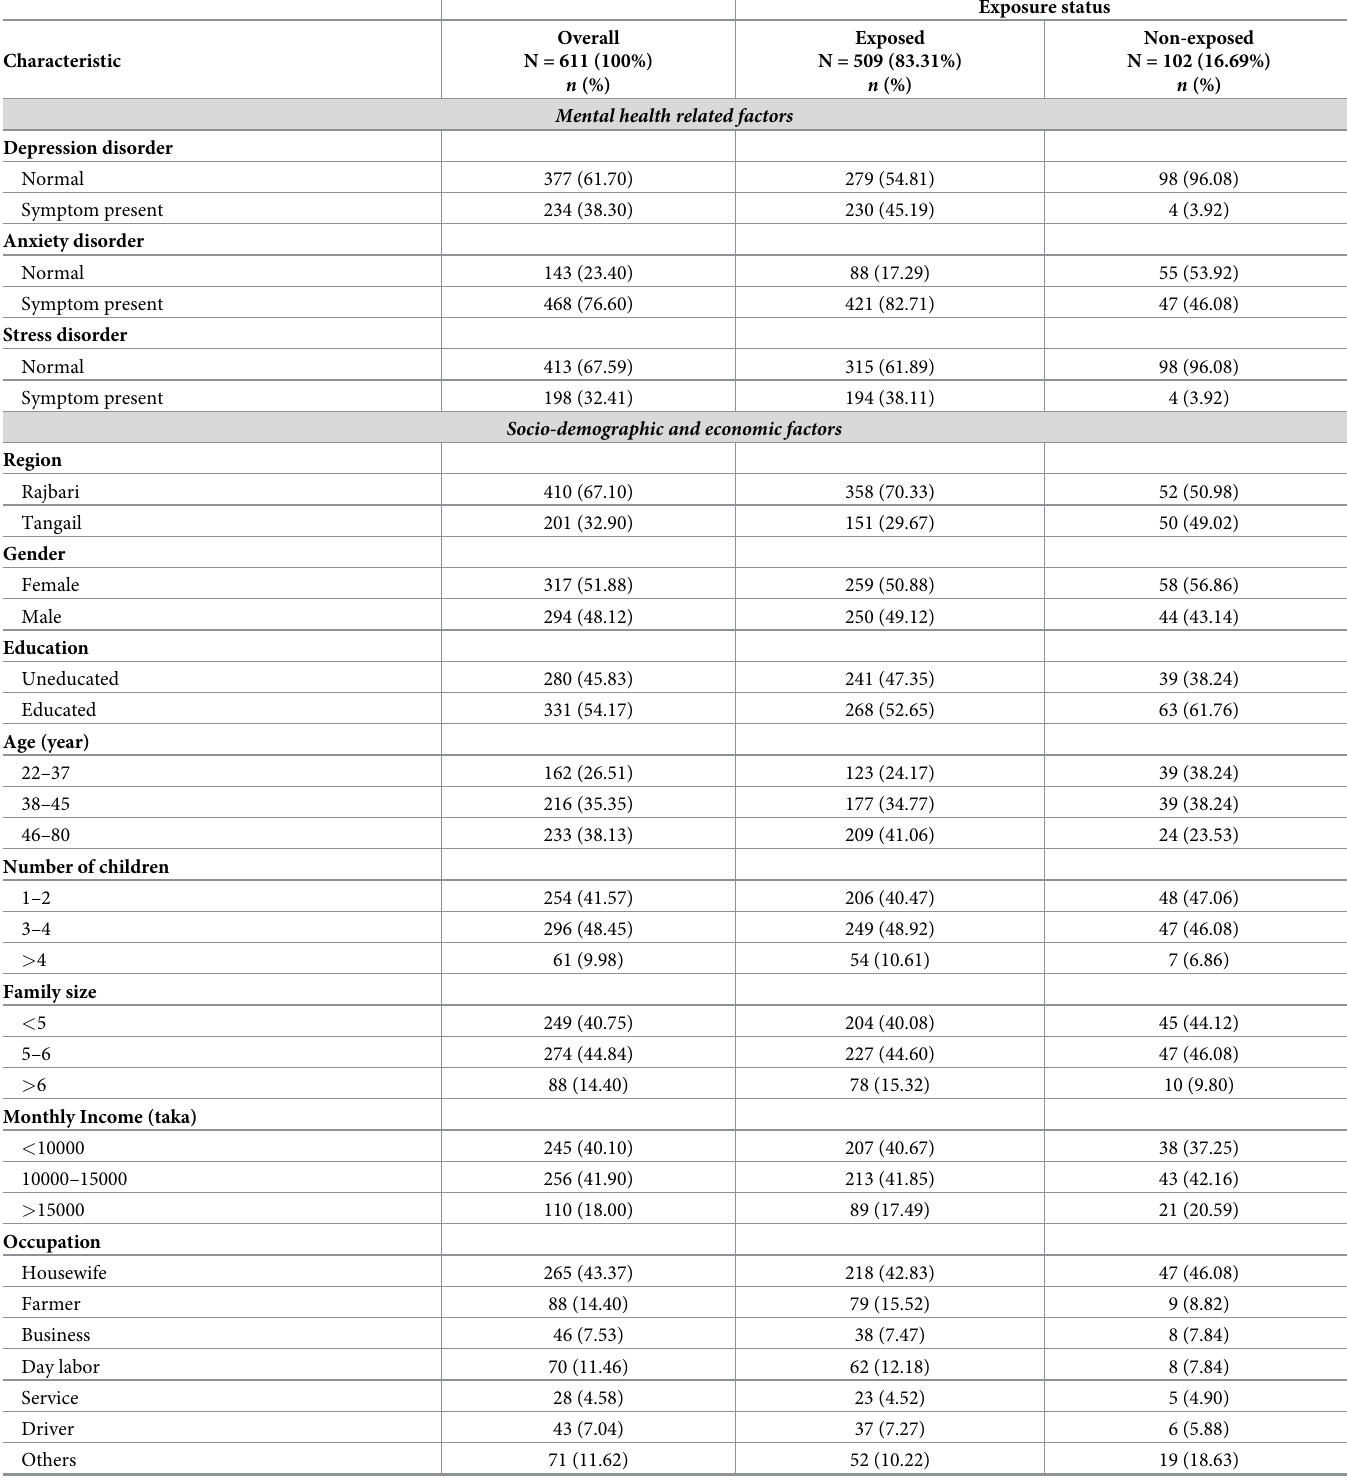
Table 1. Distribution of mental health, demographic, socio-economic and river erosion related factors by exposure status (exposed and non-exposed) in the study population (N =